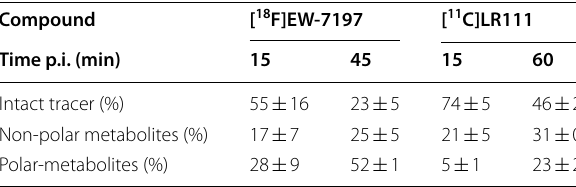
Table 2 Ex vivo metabolite analysis in blood of [ 18 F]EW-7197 and [ 11